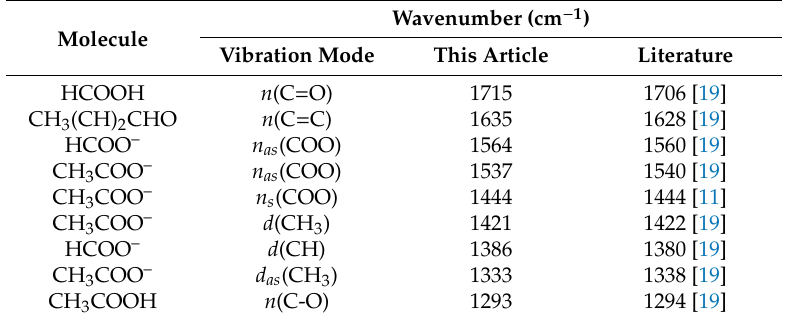
Table 5. Assignment of FTIR bands observed for commercial titania samples (P25, P90,